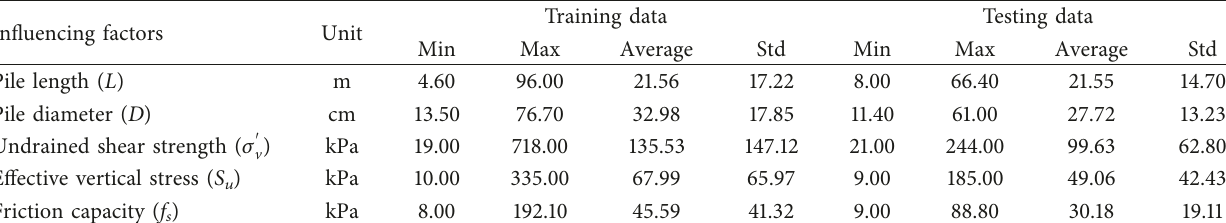
Table 2: Load test records properties and statistical